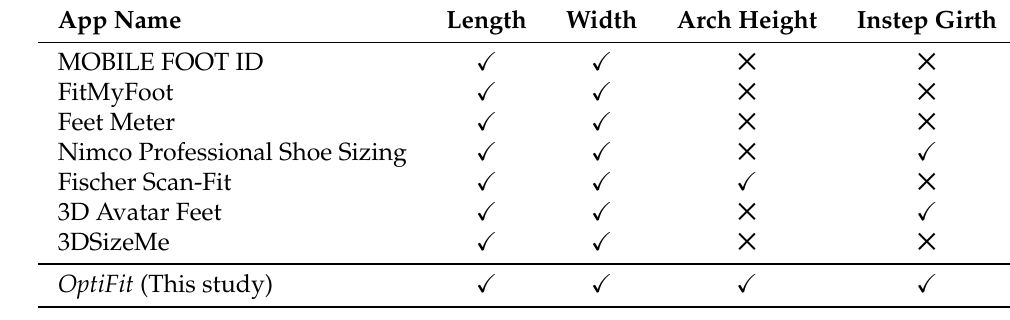
Table 1. Application review summary and